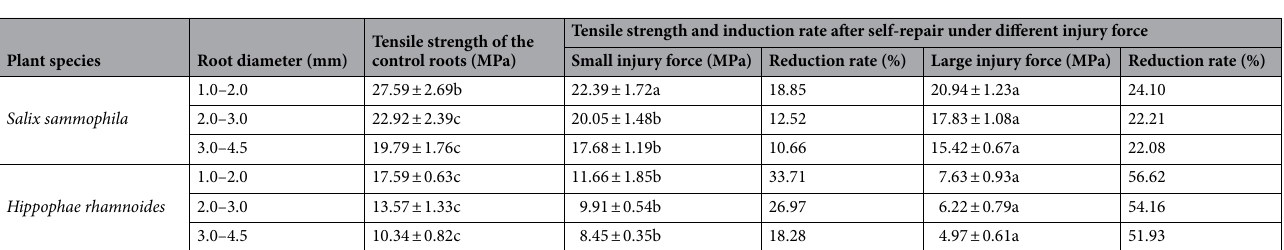
Table 5. The differences in tensile strength between 2 plants roots after self-repair and the parallel control roots.